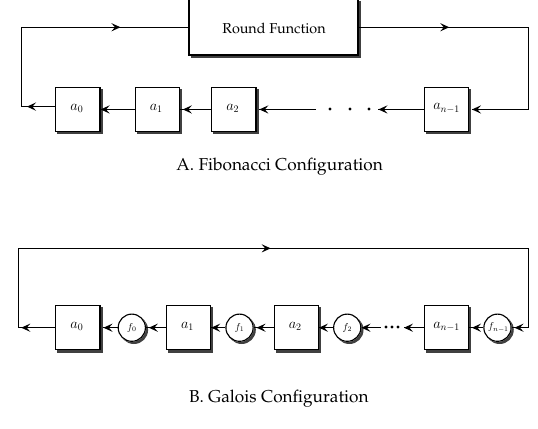
Figure 2: Fibonacci and Galois Configurations for Shift